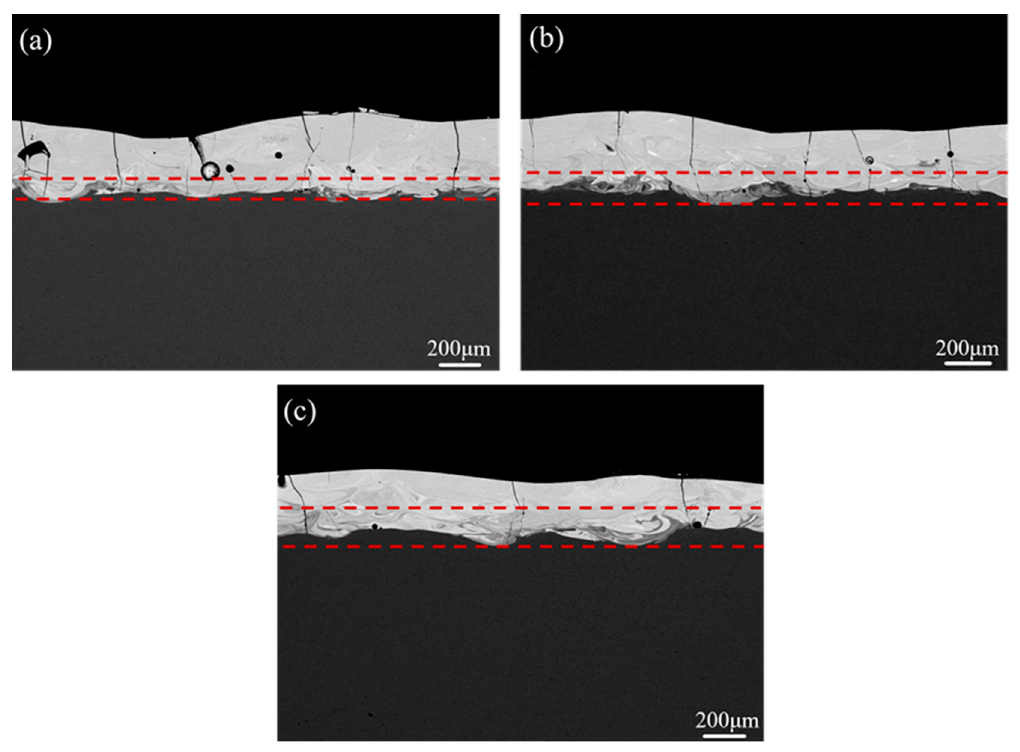
Figure 5. Backscattered electron images of Co 55 Ta 10 B 35 amorphous coating prepared by laser cladding at different substrate temperatures: ( a ) 373 K; ( b ) 473 K; ( c ) 573 K.